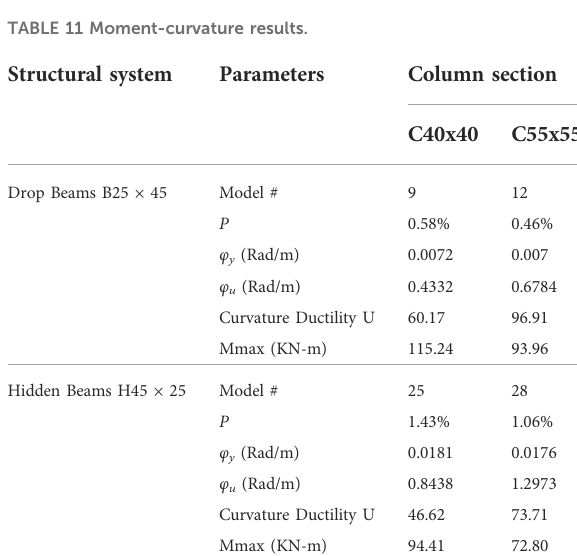
TABLE 11 Moment-curvature